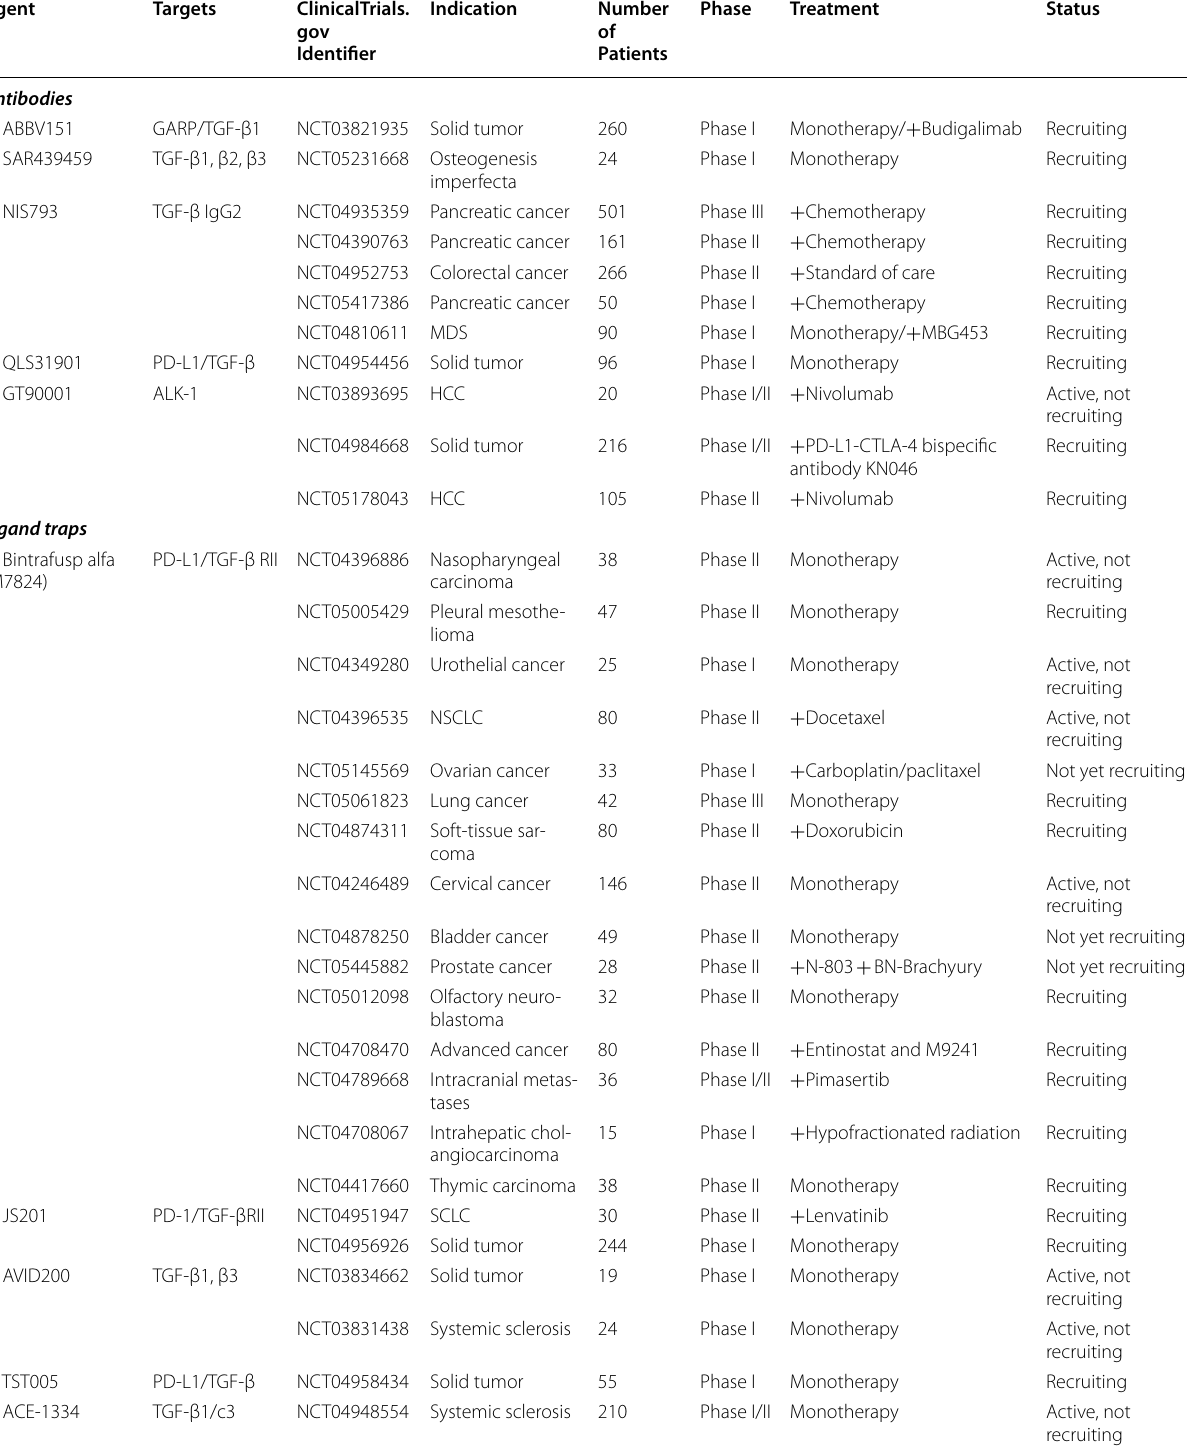
Table 1 Clinical trials that evaluated TGF-β signaling pathways antibodies and ligand traps in disease